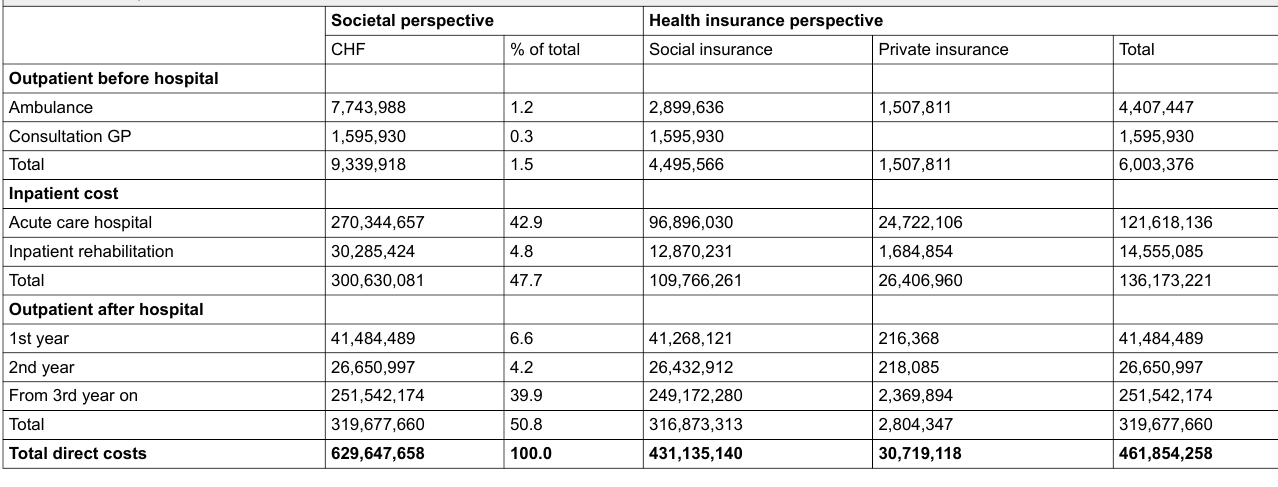
Table 7: Total direct cost and average direct cost over ACS event types (CHF). Own calculation, present value of future costs calculated at 2% discount rate. UAP